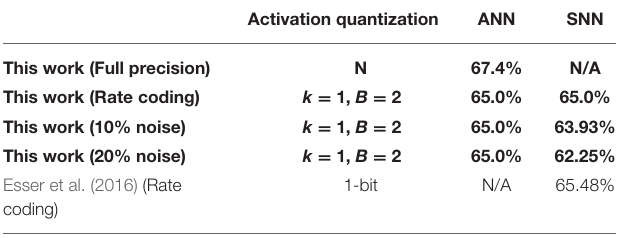
TABLE 6 | Classification accuracy on